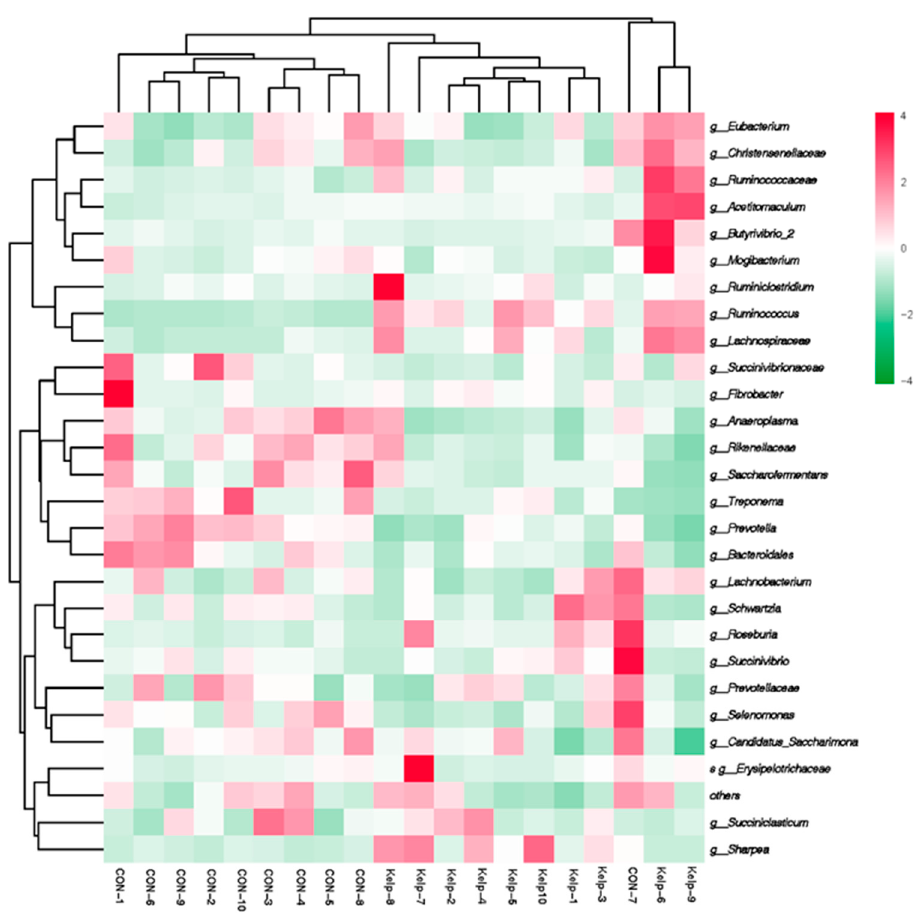
Figure 2. Hierarchical clustering analysis (HCA) and heat map analysis on abundances of ruminal bacteria content between CON and kelp treatment on the level of genera. Rows represent genera of bacteria and columns represent samples. Cells were colored based on the relative abundance of bacteria measured in rumen, red represents high rumen levels while green represents low signal intensity and white cells showing the intermediate level.